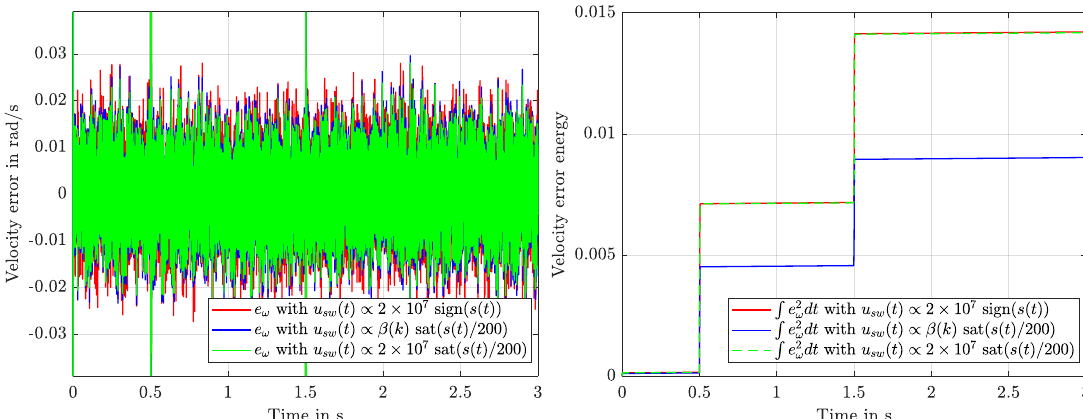
Figure 4. Simulated values for the tracking errors e ( t ) for all the variants ( left ) and the integrated squared error for all the variants ( right